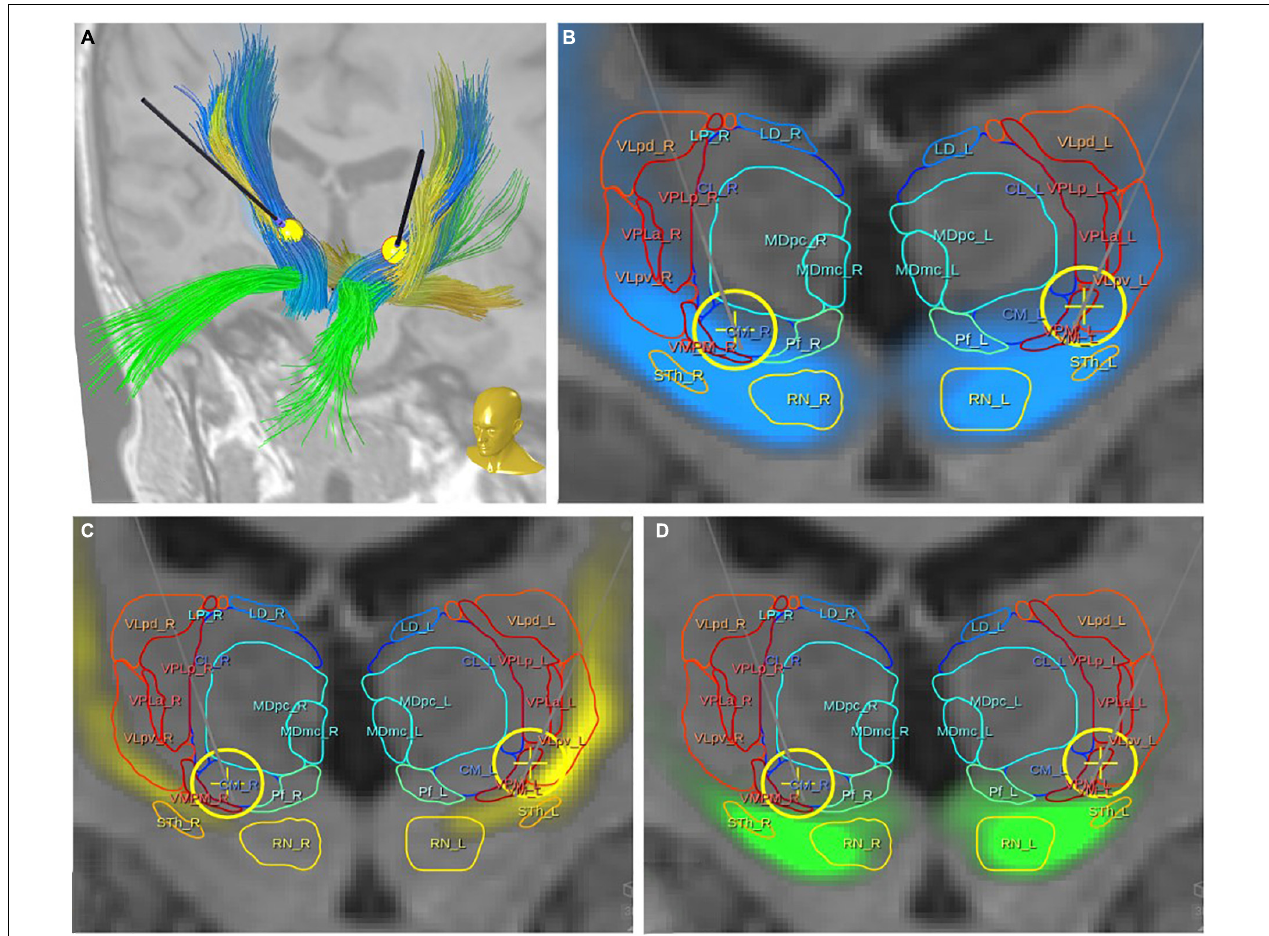
FIGURE 6 | Case #1, topographic presentation of three fiber tracts with respect to thalamic nuclei [following the atlas of Morel (2007)]. (A) Overview with DBS electrodes showing three principle fiber pathways: DRT, yellow; PFC, green; MB, blue. (B,C) Relation of the regarded fiber tracts to thalamic nuclei and DBS electrodes with simulated volumes of activated tissue (yellow spheres). All three fiber tracts have proximity with the ventro-lateral thalamic nuclei [for nuclei abbreviations refer to Morel (2007)].